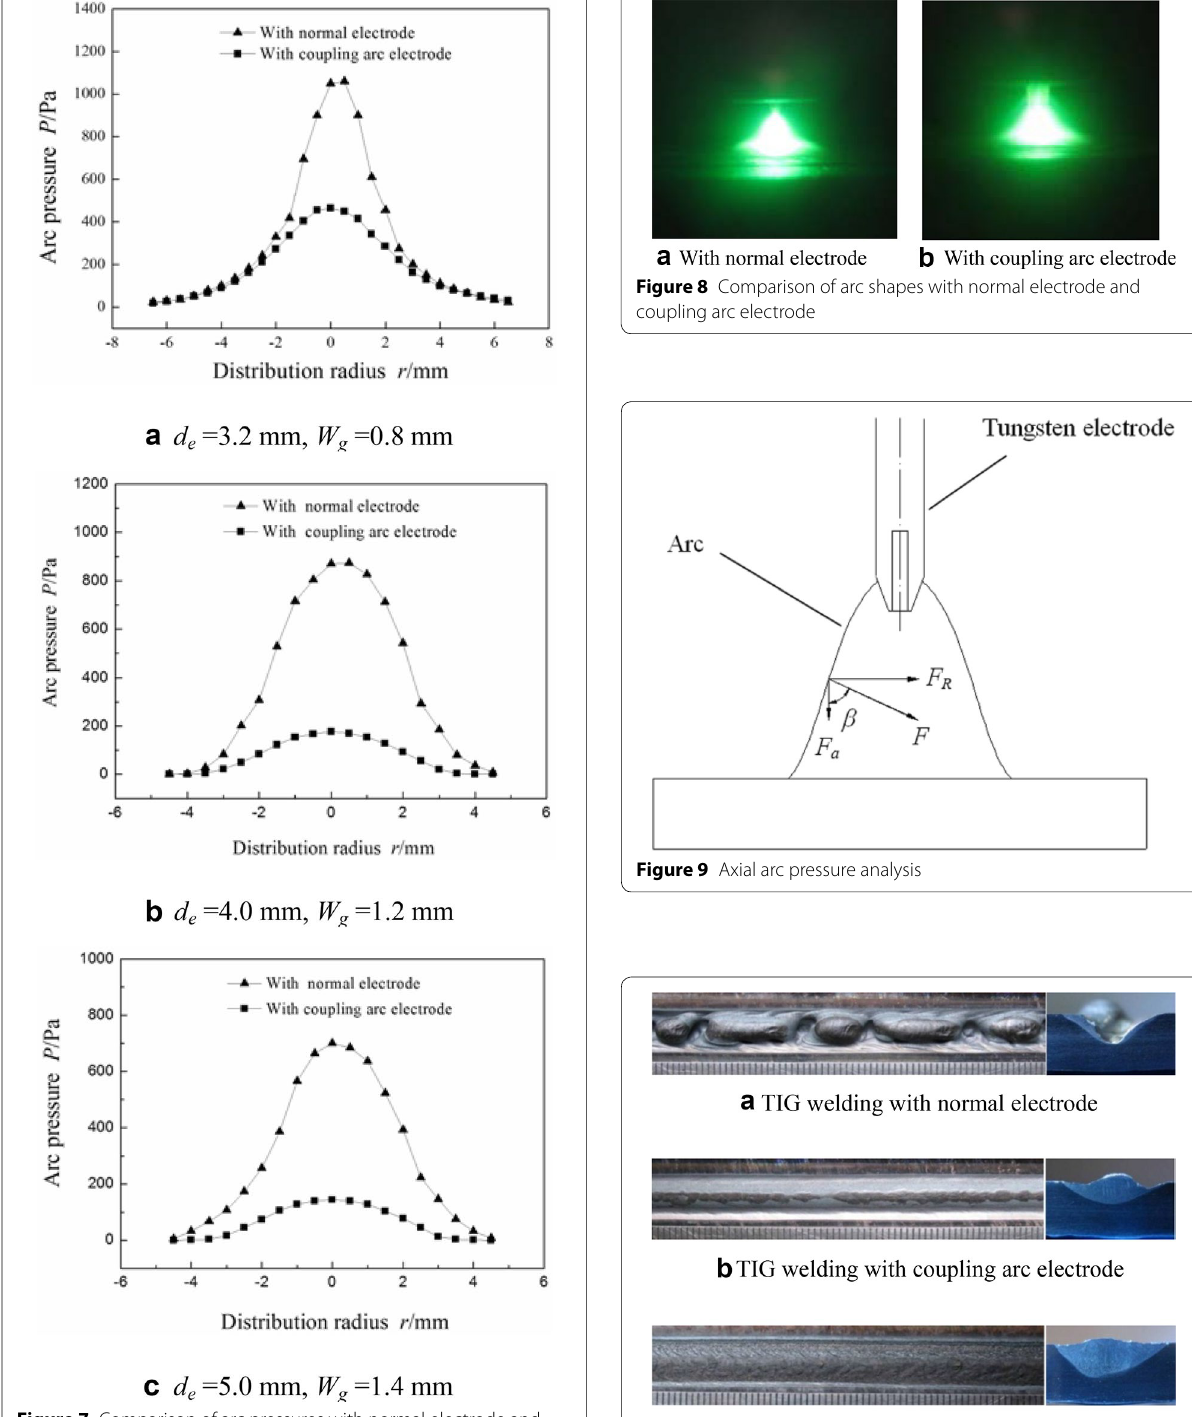
Figure 7 Comparison of arc pressures with normal electrode and coupling arc electrode